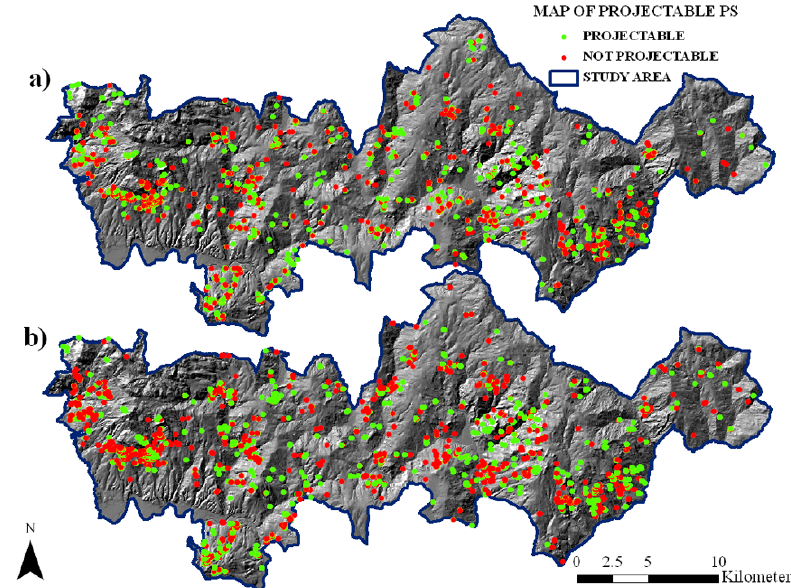
Fig. 14. The map of projectable PS for ERS (a) and ENVISAT (b)